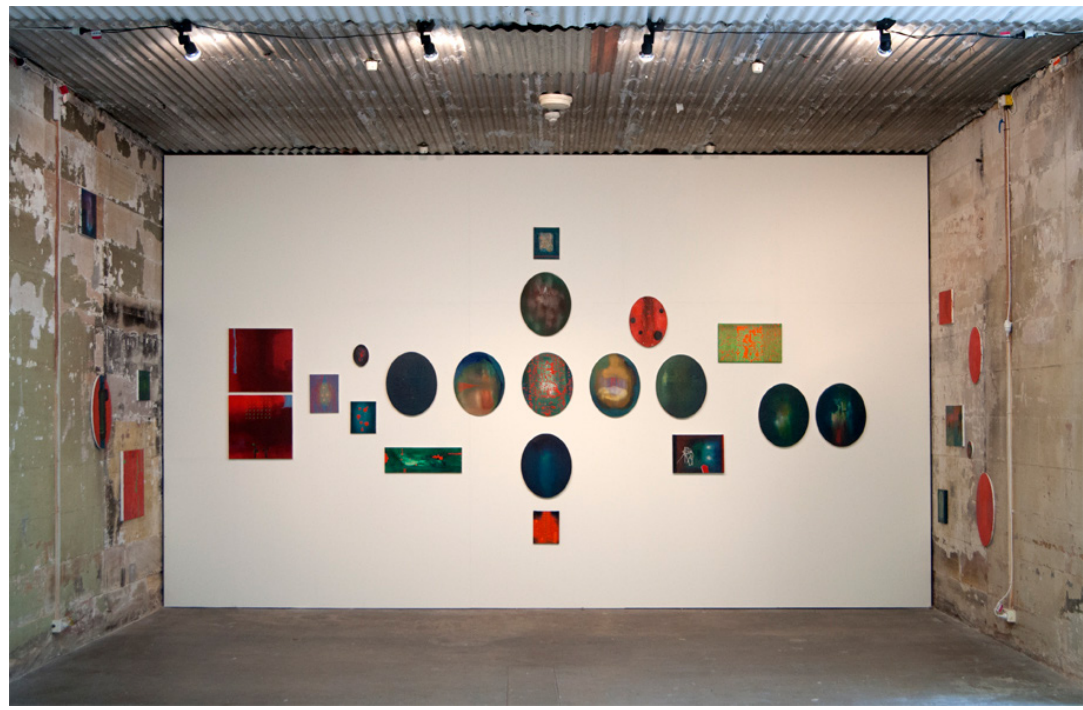
Figure 4: Jon Cattapan, The City Submerged No. 25 , 1991-2015, paintings, dimensions variable. Photo: Peter Burgess. Courtesy the artist and Dominik Mersch Gallery.